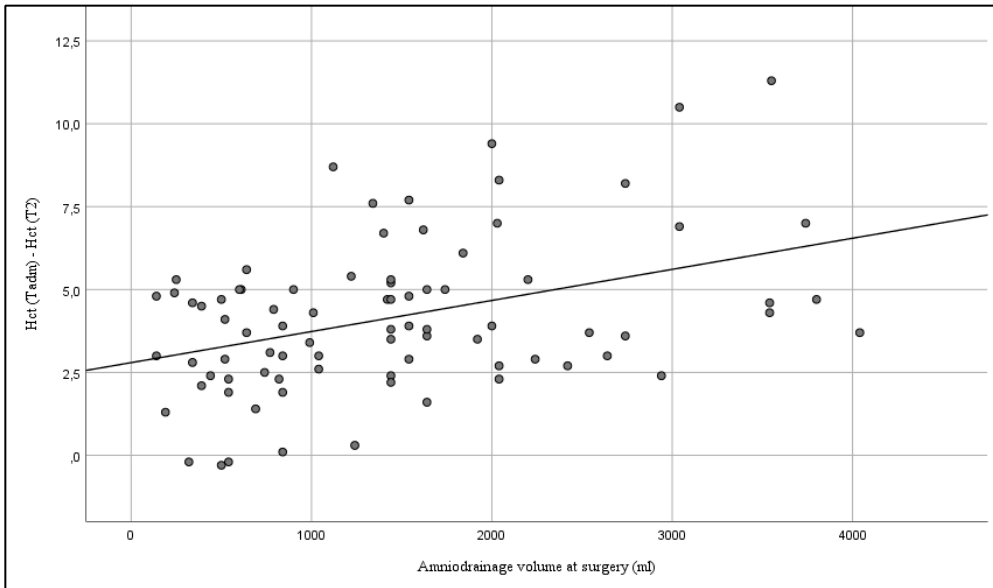
Figure 3. Correlation between the volume of amniodrainage at surgery and changes of maternal serum hematocrit (Hct) within 24 h after the intervention (Spearman’s rho 0.325; p = 0.003).